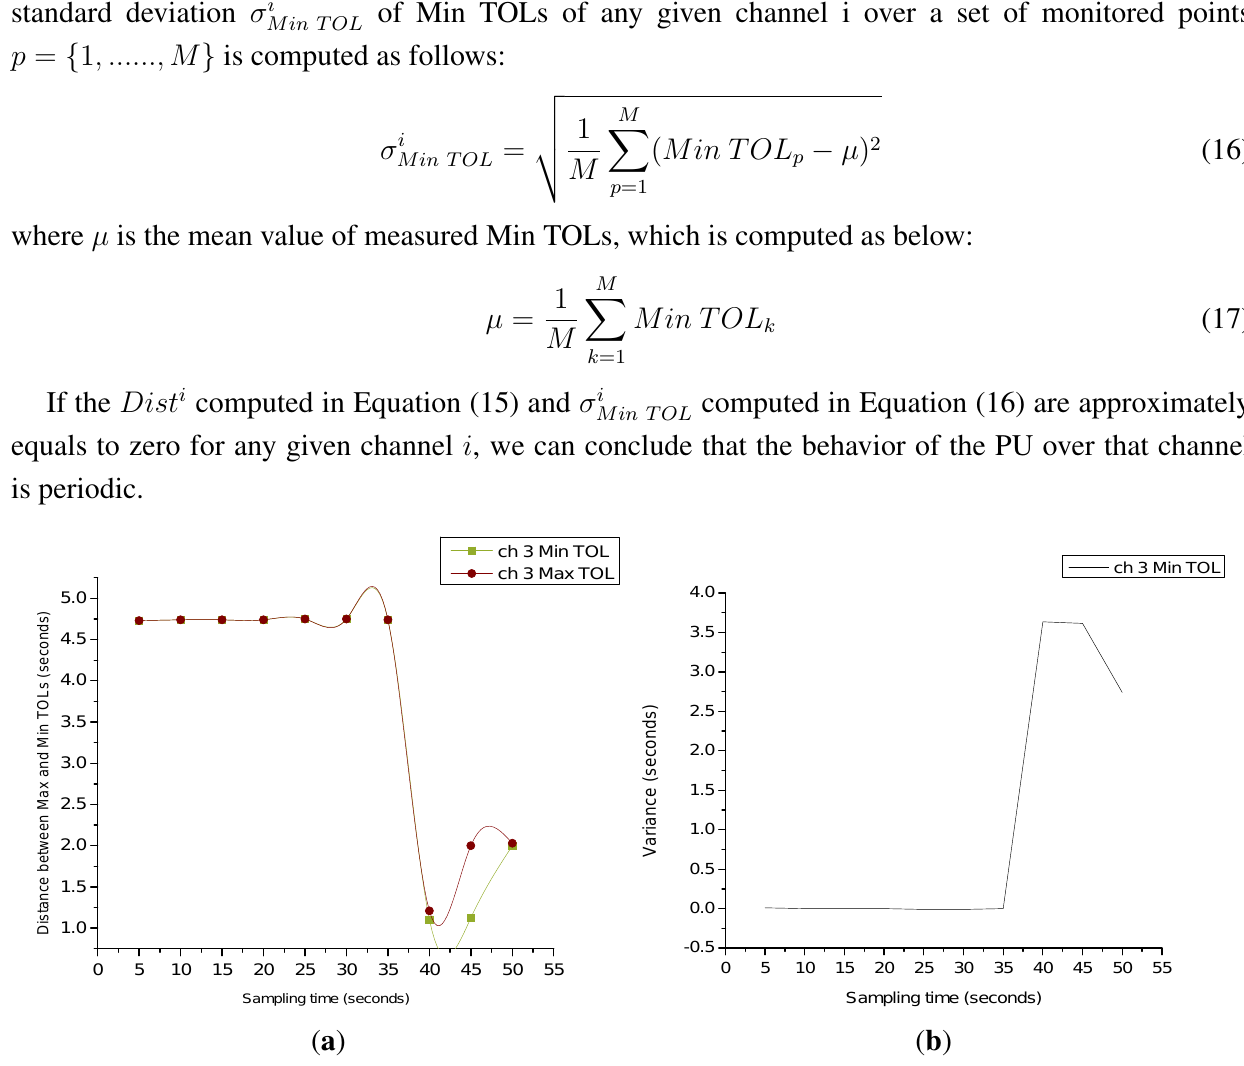
Figure 12. Distance and variance of Ch 3. ( a ) Distance between Ch 3 estimated Min TOL and Max TOL; ( b ) variance in Ch 3 estimated Min